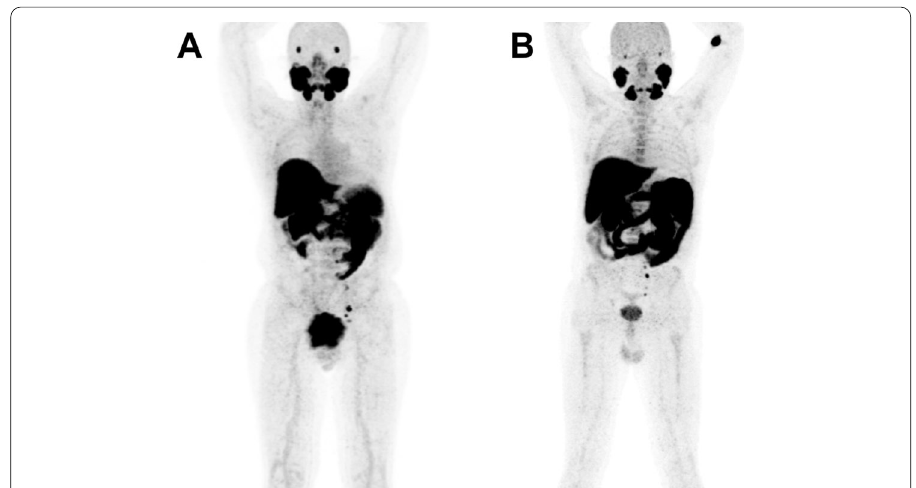
Fig. 2 Example of different patients, with similar tumor burden, acquired on the same date, but receiving the injection at different times after the EOS. Patient A was injected about one hour after the [ 18 F]PSMA-1007